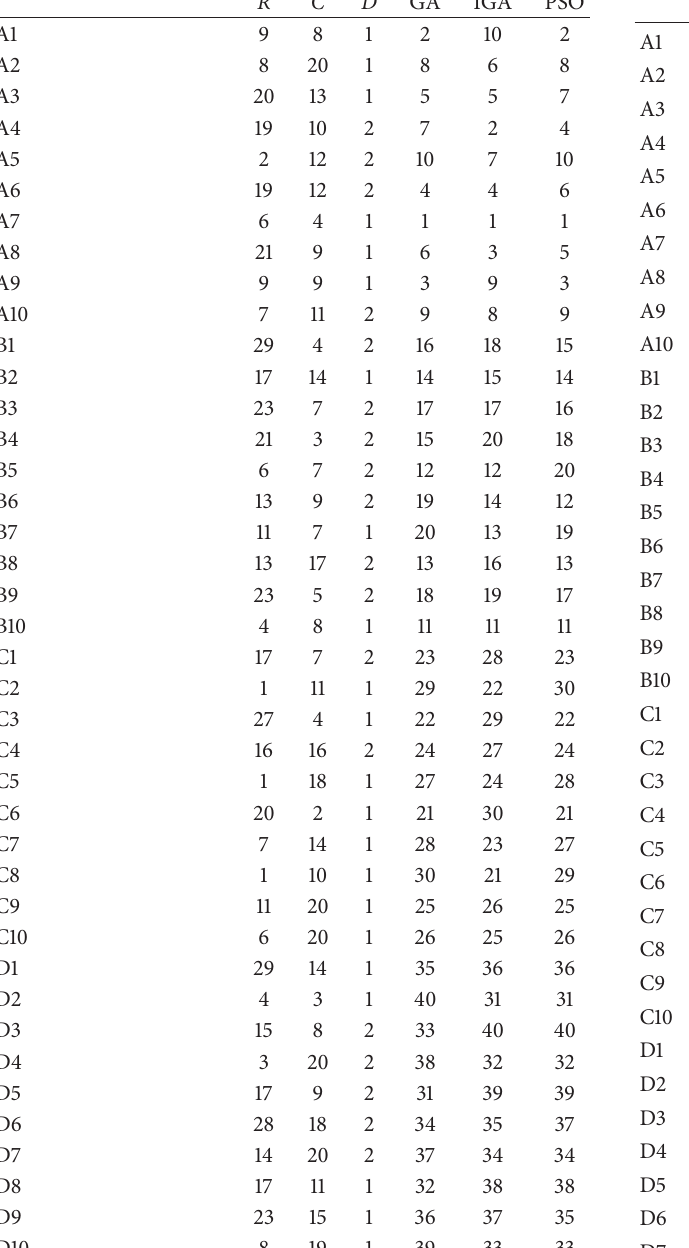
Table 2: The addresses of the stored cargo for simulation in Case 2. Type and number of